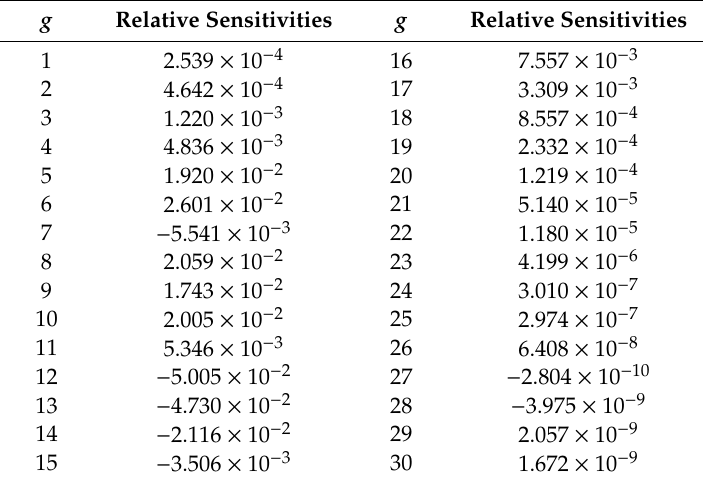
(cid:17) (cid:16) χ g , g = 1, ... ,30. i = 1